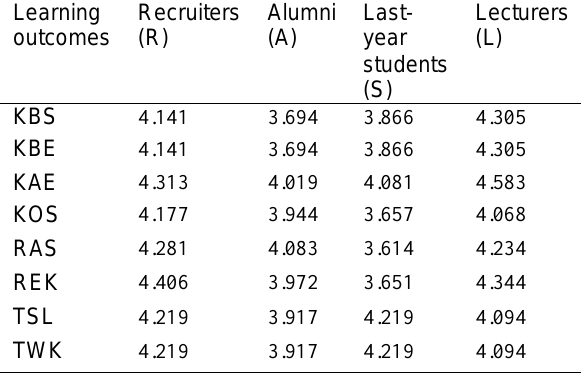
Table 4. The statistics on the expectation of students’ acquirement of learning outcomes (Source: Survey of Tuyet Anh Thi Nguyen in a study funded by TDMU in 2016)